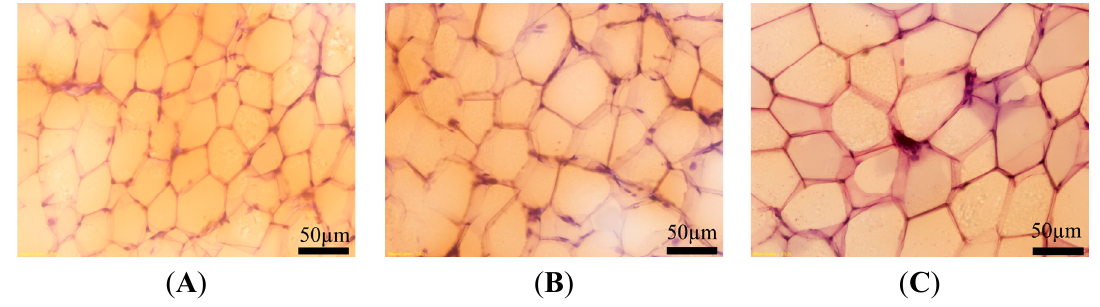
Figure 4. Effect of perinatal exposure to BPA on morphological difference of subcutaneous adipocytes for male offspring at adult stage. Pregnant rats ( n = 7/group) were exposed to vehicle or BPA in water at levels of 1 or 10 µg/mL from gestation day 6 through the end of lactation. Histological sections of subcutaneous adipocytes with Oil red O were made in male offspring at adult stage from each group. Image ( A – C ): Representative histological sections of subcutaneous adipose tissue from F1-control, F1-BPA1 and F1-BPA 10